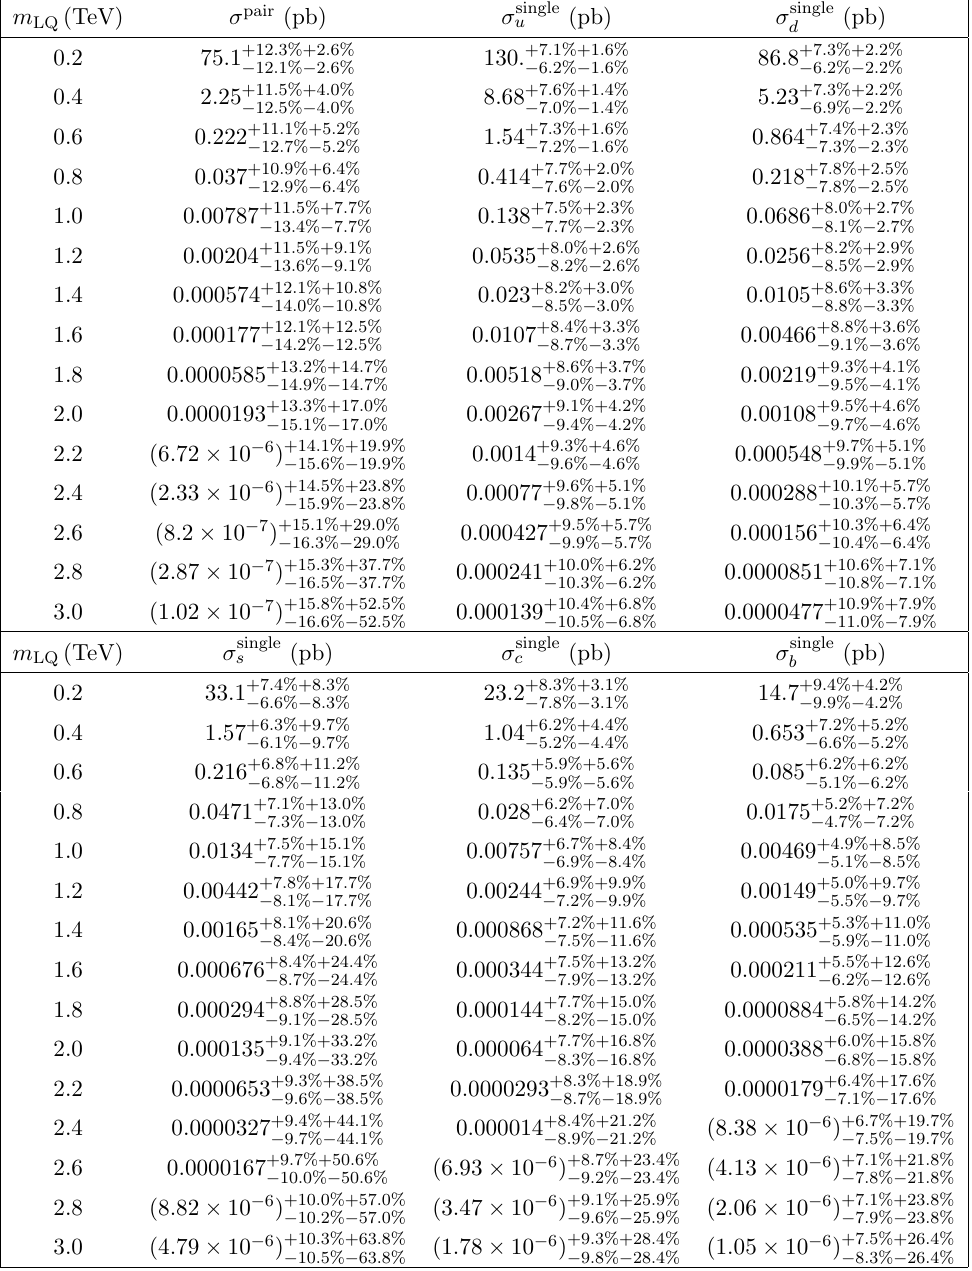
Table 2 . Total inclusive cross sections in pb for the PDF4LHC15 PDF sets [29] as a function of the LQ mass at 14 TeV center-of-mass energy for the proton-proton collisions. (cid:27) pair corresponds to the LQ pair production. (cid:27) single describe single LQ productions through corresponding quark (cid:13)avour u;d;s;c;b when the associated Yukawa coupling strength is set to one. The cross section dependancy on the change in the renormalisation ( (cid:22) R ) and factorisation ( (cid:22) F ) scales is taken into account through the following scale variations: (cid:22) R = (cid:22) F = m LQ = 2 ; m LQ ; 2 m LQ . First (second) uncertainty is due to the renormalisation (cid:22) R and factorisation (cid:22) F scale (PDF) variations and is given in per cent